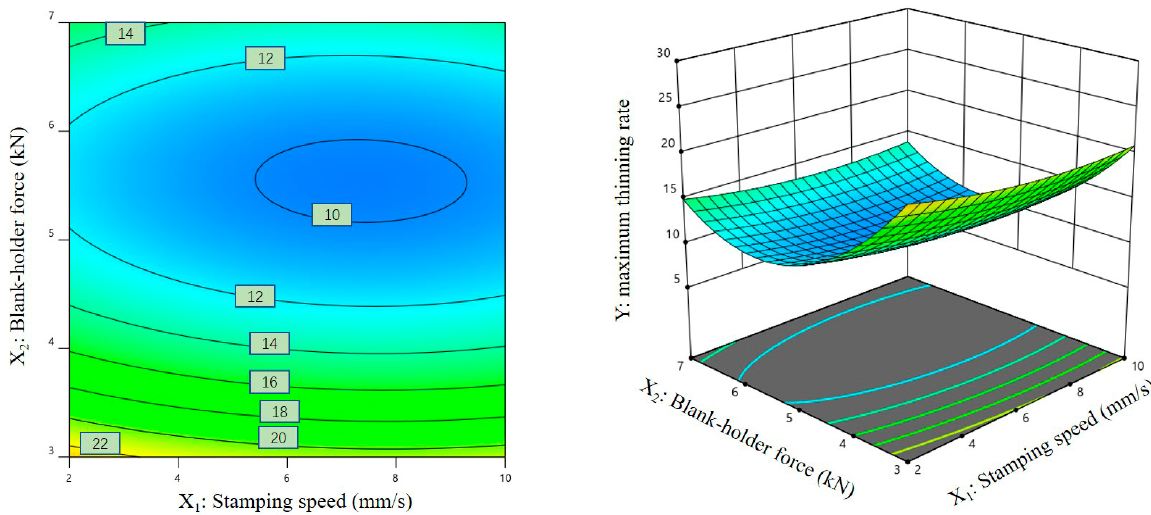
Figure 7. Contour plot and three-dimensional response surface graph of X 1 -X 2 on Y.